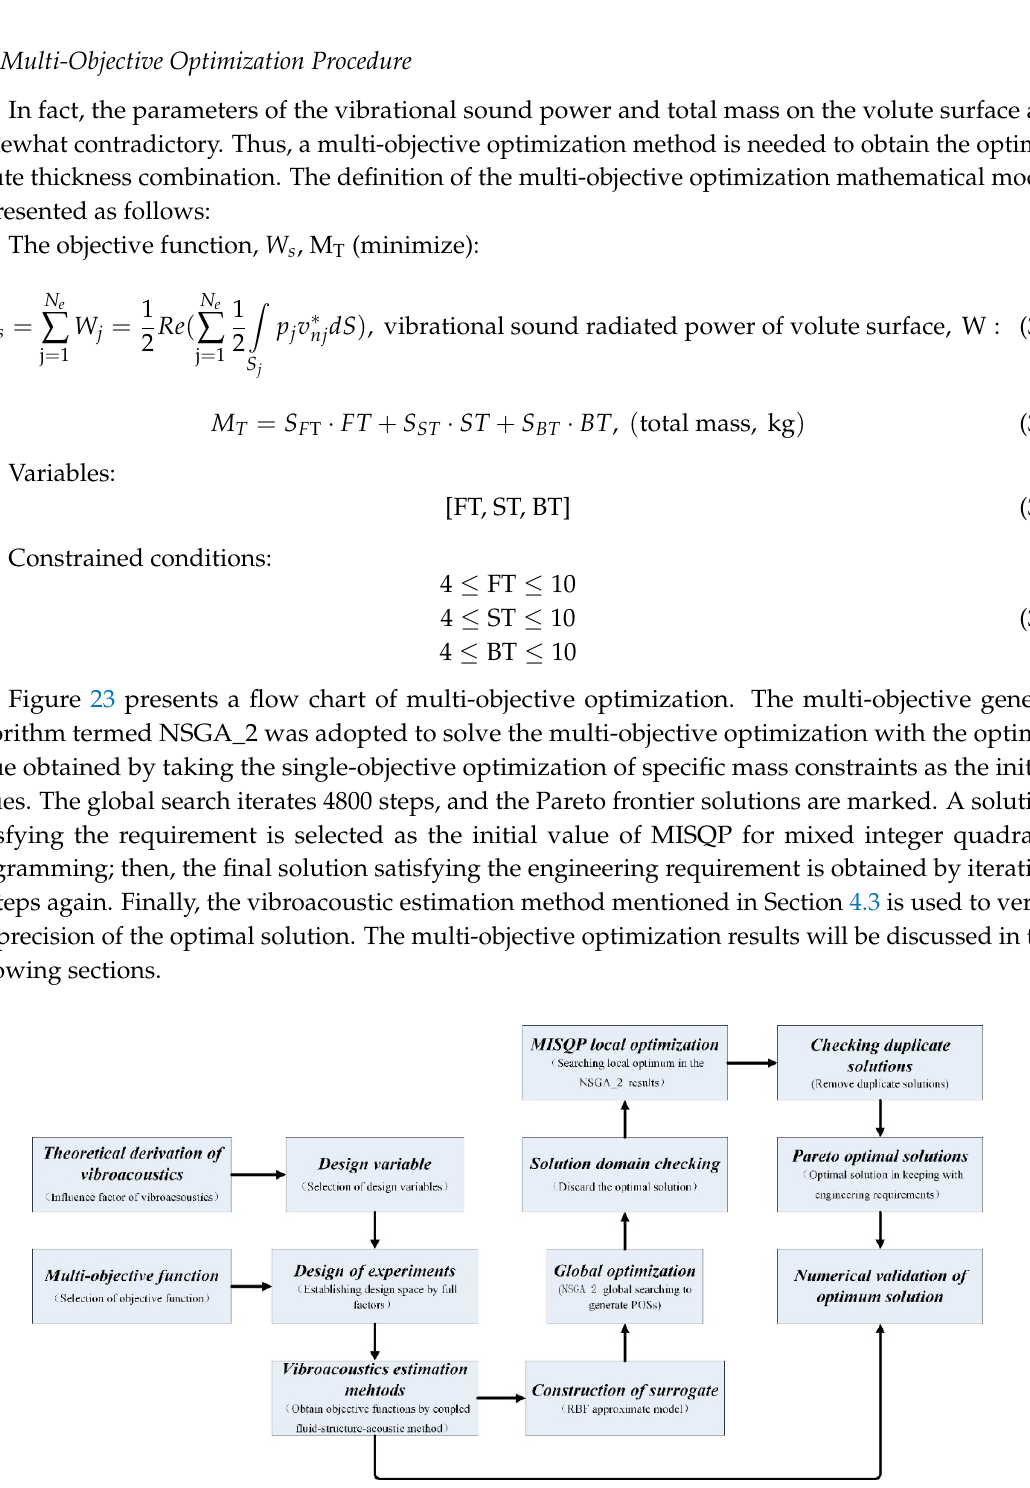
Figure 23. The flow chart of multi-objective optimization.